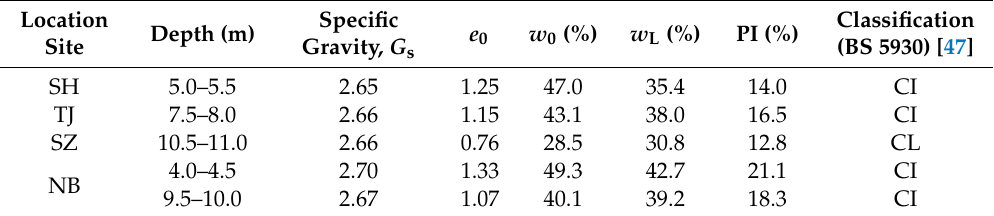
Table 5. Physical properties of soft soils.